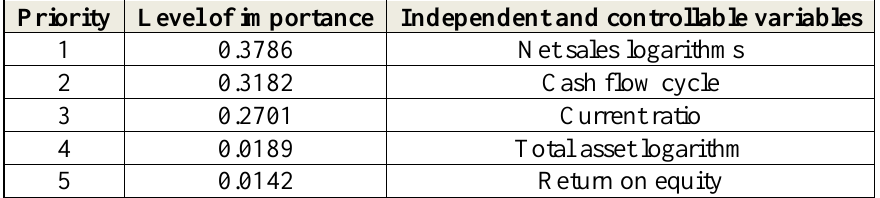
Table 9. How to enter variables into the neural network